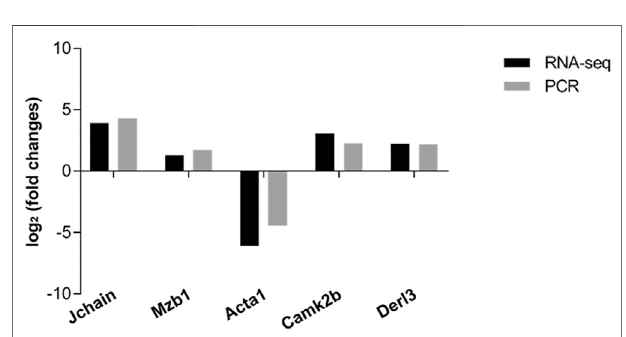
FIGURE 4 | Validation of RNA-sequencing data by qRT-PCR. Five differentially expressed mRNAs were validated by qRT-PCR, including four up-regulated mRNAs and one down-regulated mRNA. The heights of the columns in the chart represent the mean expression value of log2 fold changes (smoke/control). All data were normalized to β -actin gene